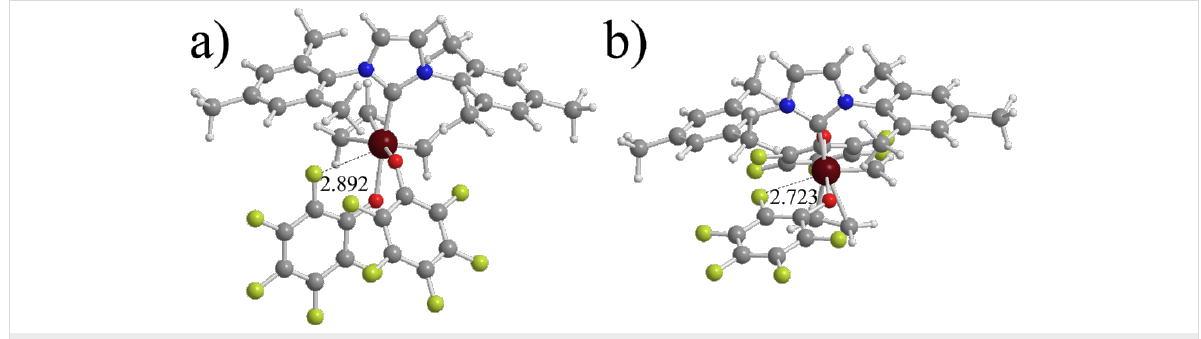
Figure 4: System 9 with a Ru … F interaction in the cis and trans geometries, parts a and b, respectively (distance in Å).